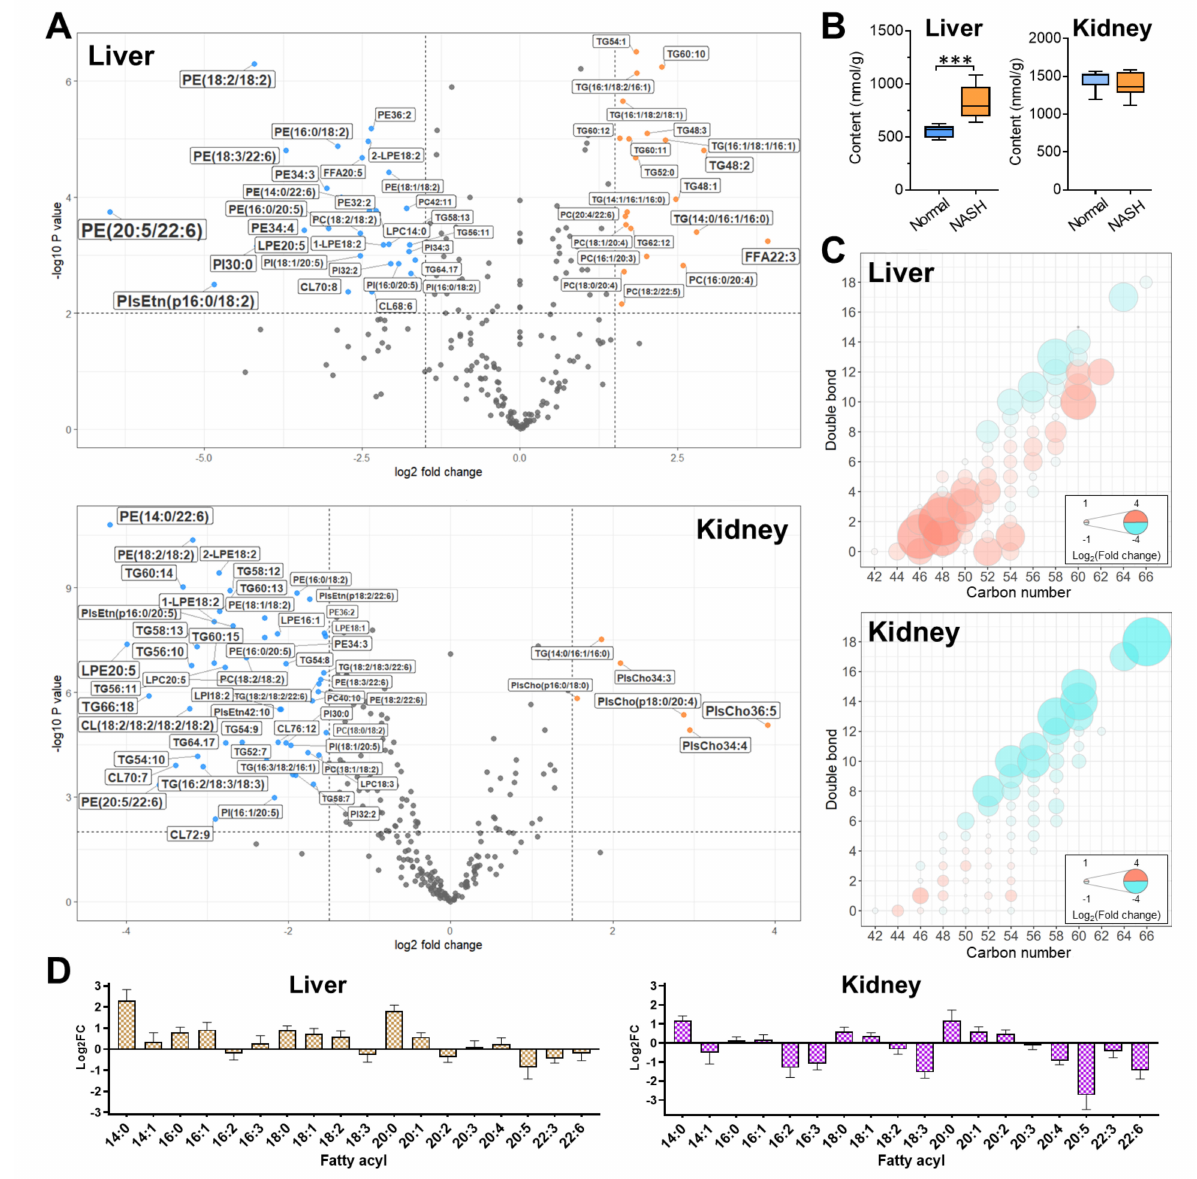
Figure 2. ( A ) Volcano plots for the changes of the lipids in liver and kidney between normal and NASH groups. Significance was defined with both p < 0.01 and |log 2 (fold change)| > 1.5, and the significantly changed lipids are indicated in orange (increased in NASH group) or blue (decreased in NASH group). ( B ) Comparison of total TG between the normal and the NASH groups in liver and kidney. *** p < 0.001, calculated by two-tailed t -test. ( C ) Bubble plots of TG profile changes in the liver and the kidney in the NASH group. The color (ranging from red to cyan) and the bubble scales represent the degree of the difference, calculated as log 2 (fold change of NASH to normal). ( D ) The changes for the fatty acyl composition of TG in NASH liver and